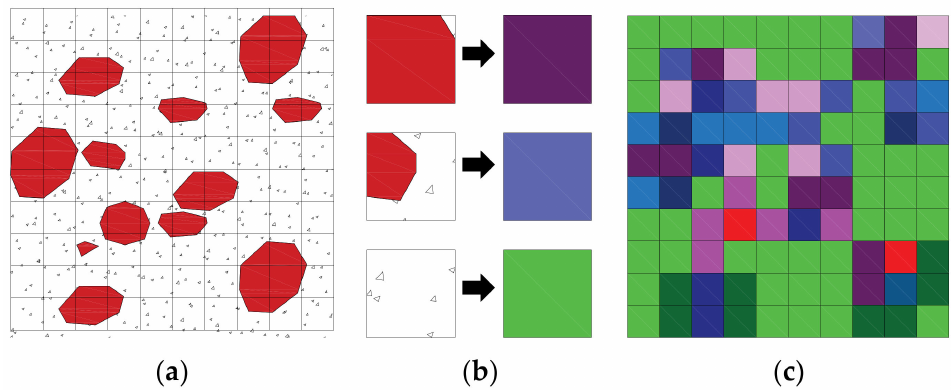
Figure 11. Method of meso-element equivalence. ( a ) Random aggregate model. ( b ) Equivalent process. ( c ) Equivalent meso-element